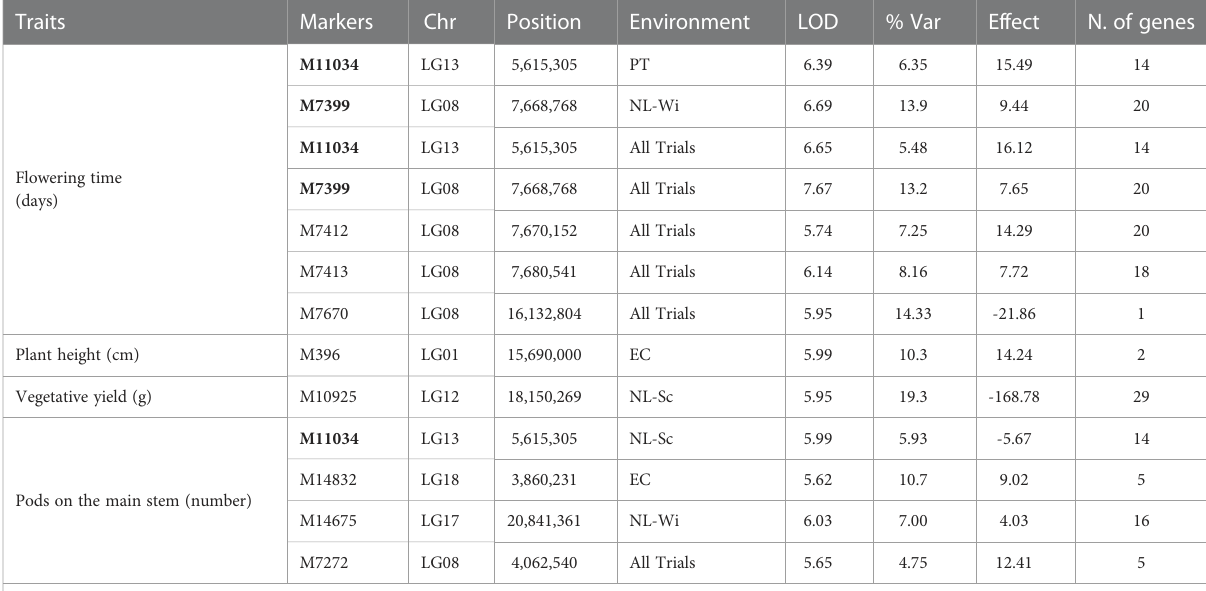
TABLE 2 SNPs found in signi fi cant association with plant-architecture and yield related traits for 223 accessions of L. mutabilis grown in four different environments.